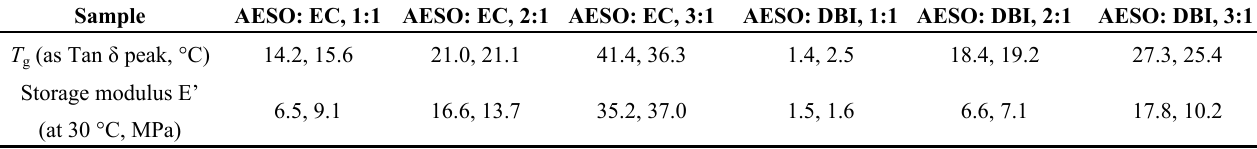
Table 2. Glass transition and viscoelastic properties of AESO blends (Each measurement was made on two different